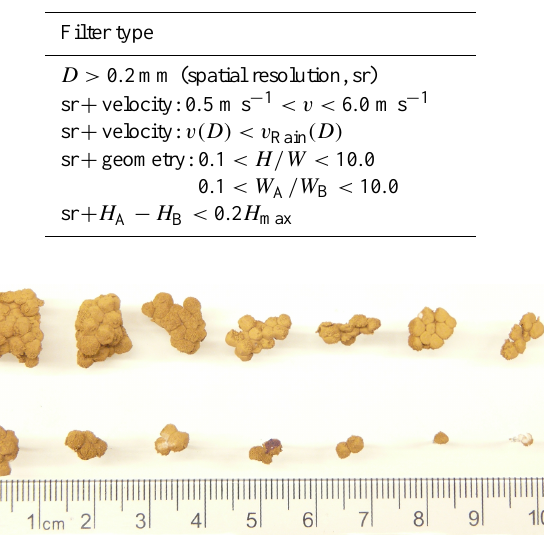
Table 1. Filter criteria for the test of the original matching algorithm (adapted from Hanesch, 1999). D is the maximum dimension, v the vertical velocity and H A / B and W A / B are the width and height measured in camera A and B.